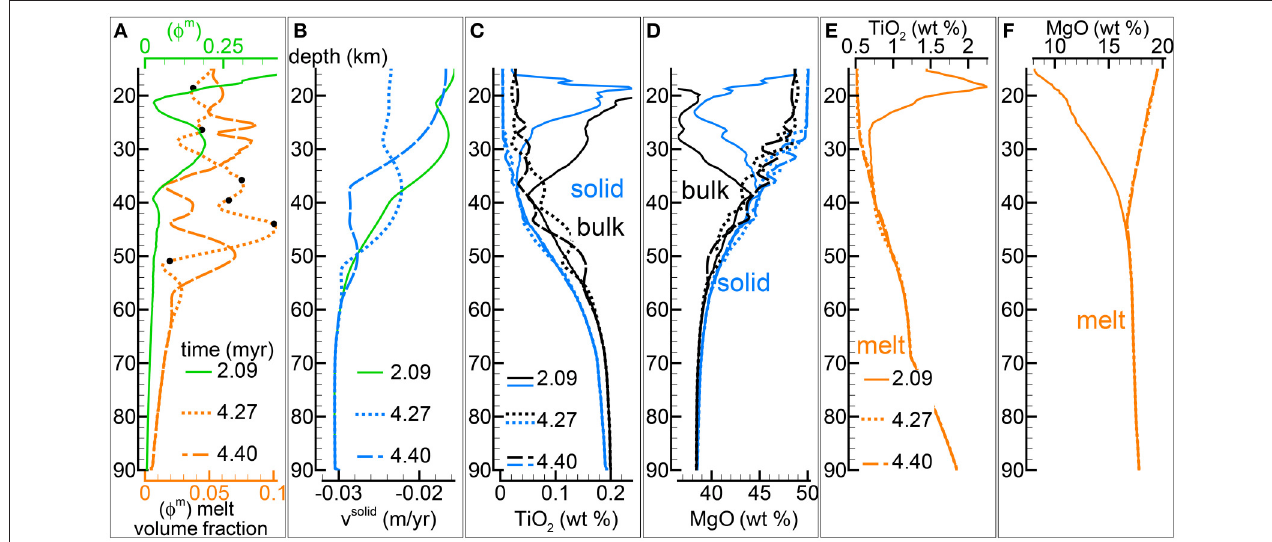
FIGURE 4 | Two-phase flow dynamic melting with thermodynamic computation applied every 8 time steps, solid viscosity model: µ s = µ s 0 with µ s 0 , equal to 1 e 21 Pa s. Additional details related to this simulation are discussed in section “Results from the Dynamic Equilibrium Melting Model.” (A) Melt volume fraction vs. depth at 3 different times. Earliest time corresponds approximately to the first arrival of melt at the top. Black dots mark the locations at which mineralogical compositions and volume fractions are reported in Table 2 . (B) Velocity of the solid matrix. (C) Variation of TiO 2 in solid and bulk (melt + solid) (wt %). (D) Variation of MgO in solid and bulk (melt + solid) (wt %). (E) Variation of TiO 2 in melt (wt %). (F) Variation of MgO in melt (wt %). The complete data for all 12 oxides in melt solid and bulk, at every depth over time can be found in the data file PHASE3-P.YRC4.DAT (zip file max-front1-data.zip ). A movie of this simulation is also available (movie file mf1-movie3.PHASE3-P.YRC4.avi ). Both files can be retrieved following the data repository link included in the Supplementary Material.